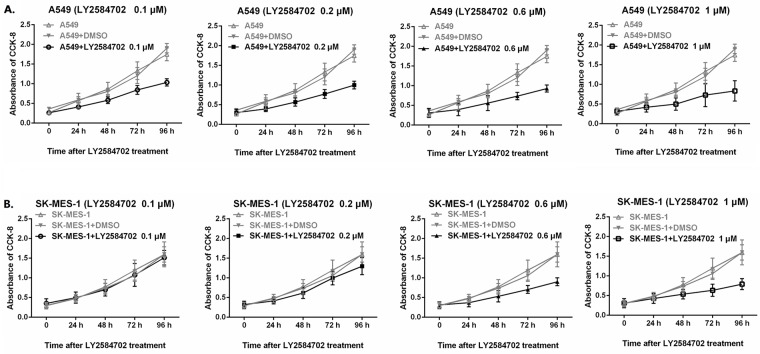
Proliferation alteration of NSCLC cell lines with RPS6KB1 dephosphorylation by LY2584702 (CCK-8 analysis).Cell lines A549 (A) and SK-MES-1 (B) with different LY2584702 concentrations treatment were detected by CCK-8 kit for the proliferation alterations. Cell lines with regular culture or culture medium with DMSO were controls. The obvious inhibition in A549 was observed at LY2584702 0.1 μM for 24 h (P = 0.035 and 0.02 when compared with A549 in regular culture or culture medium with DMSO, respectively); while in SK-MES-1, the change became detectable at 0.6 μM for 24 h (P = 0.042 and 0.036 when compared with regular culture or culture medium with DMSO, respectively). Both of A549 and SK-MES-1 showed significant time- and concentration-dependence. Data were repeated six times independently.